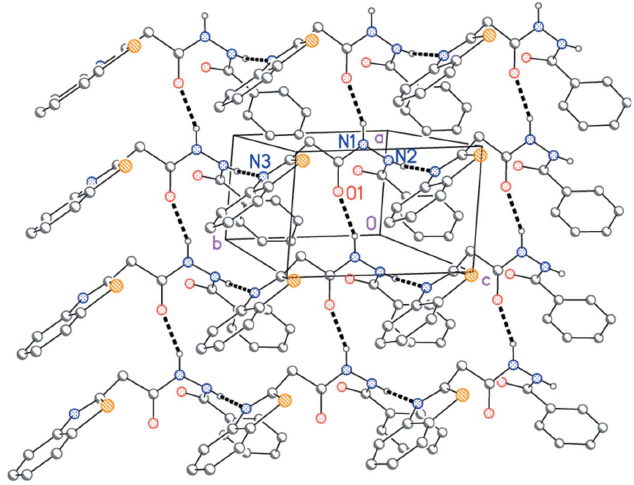
Figure 2 Packing diagram of compound 3 viewed perpendicular to the ab plane. Dashed lines represent classical hydrogen bonds. Hydrogen atoms not involved in hydrogen bonding are omitted for clarity. Selected atoms of the asymmetric unit are